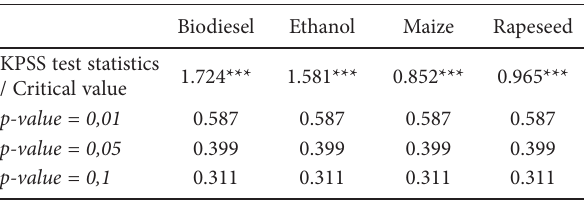
Table 1. Results of stationarity tests with regard to the analyzed time series.